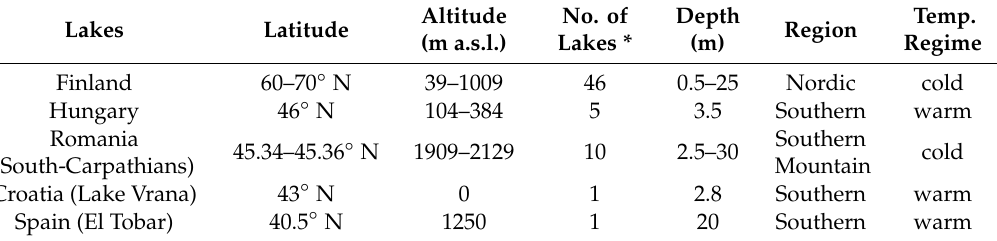
* at least one of the target species was